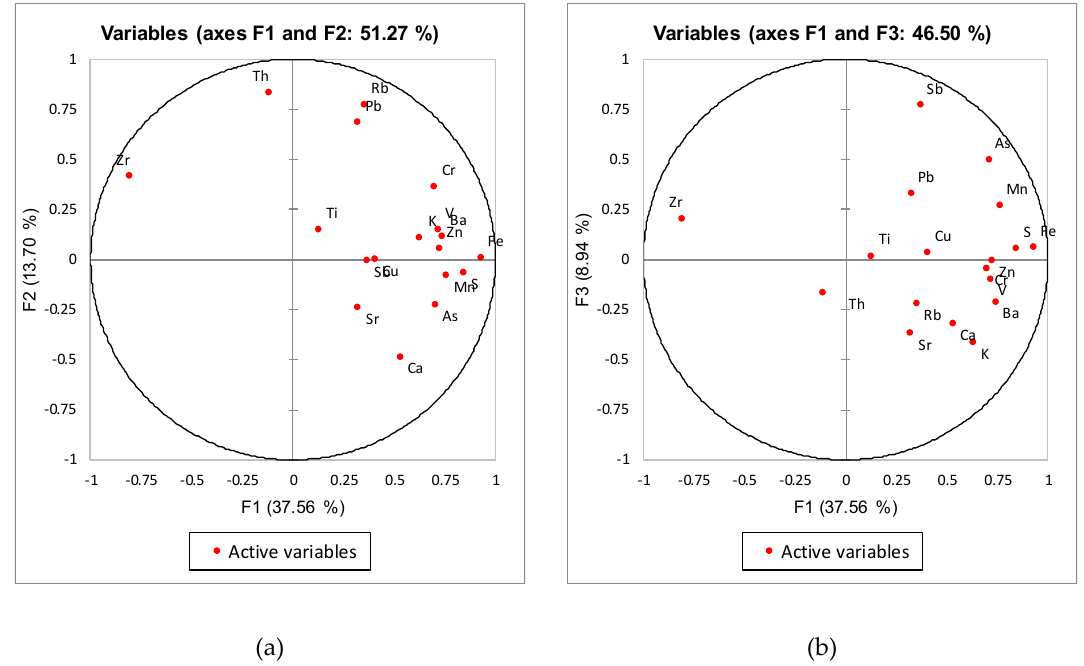
Figure 6. PCA factor diagrams for F1-F2 ( a ) and F1-F3 ( b ). Samples from B horizon, pXRF clr data.